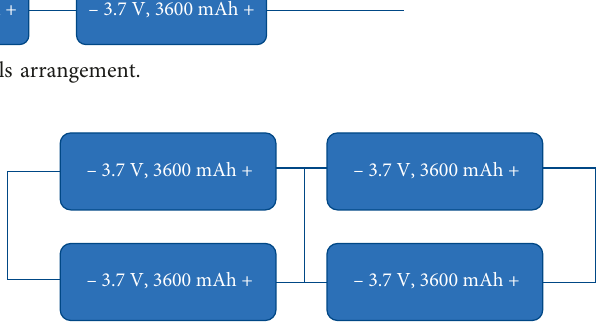
Figure 6: Serial-parallel